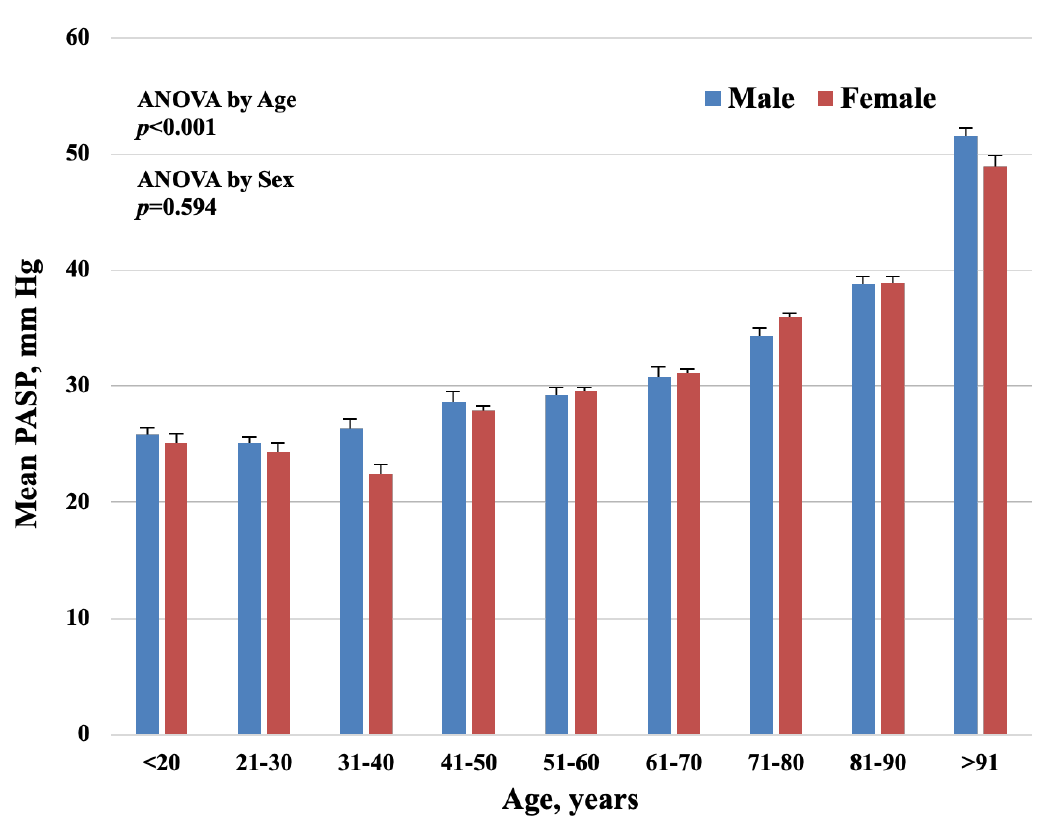
Figure 3. Distribution of study population by age shows a significative increase in age-related mean PASP ( p < 0.0001). No significant difference by sex ( p = 0.594). The interdependence analysis showed a significant correlation between PASP and left atrium size ( r = 0.354, p < 0.0001) and left ventricular ejection fraction ( r = −0.235; p < 0.0001). In addition, PASP was also correlated to the right atrial size ( r = 0.272, p < 0.0001) and right ventricle size ( r = 0.221, p < 0.0001). By the multivariate logistic regression analysis in the overall study population, age, female sex, right atrium/right ventricle/left atrial dilatation, left ventricular ejection frac- tion (LVEF), and tricuspid annular plane systolic excursion (TAPSE) were independent predictors of PASP, as shown in Table 3.